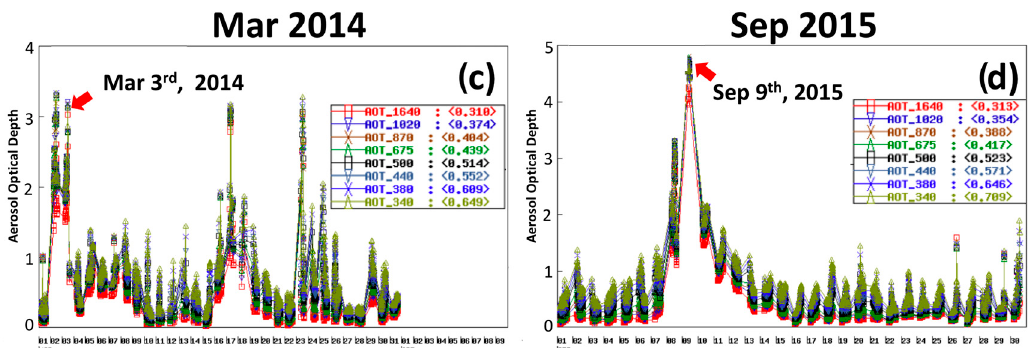
Figure 4. Time series of AERONET monthly AOD during ( a ) June 2013, ( b ) January 2014, ( c ) March 2014, and ( d ) September 2015. Red arrows point to the high AOD anomalies events during each month: 8 June, 2 January, 3 March, and 9 September, respectively.